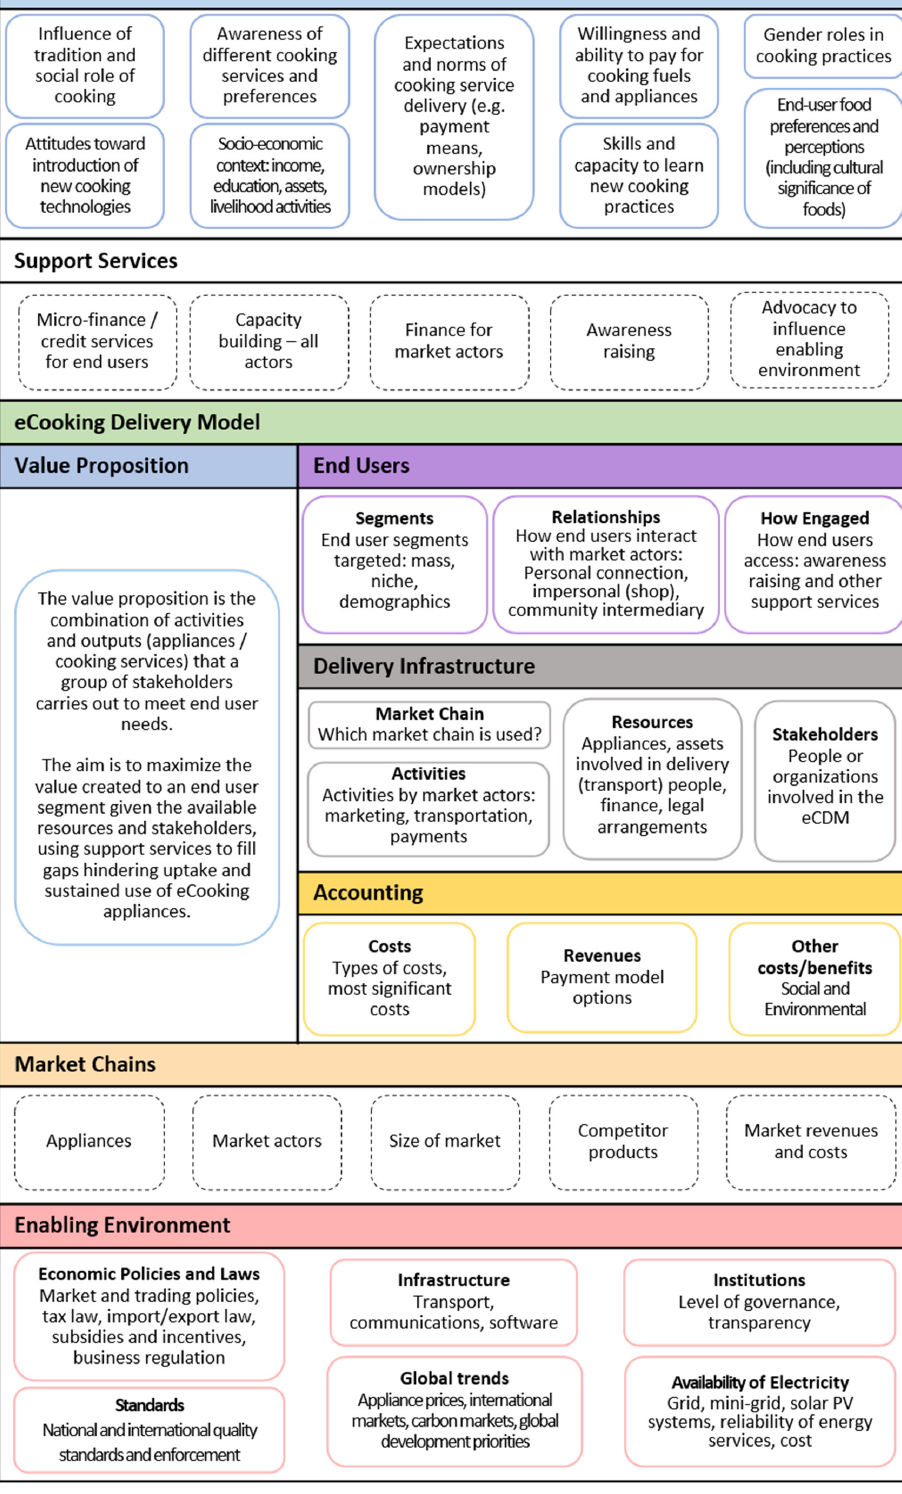
Figure A2. eCooking Market System map (Authors’ own, adapted from [17]).